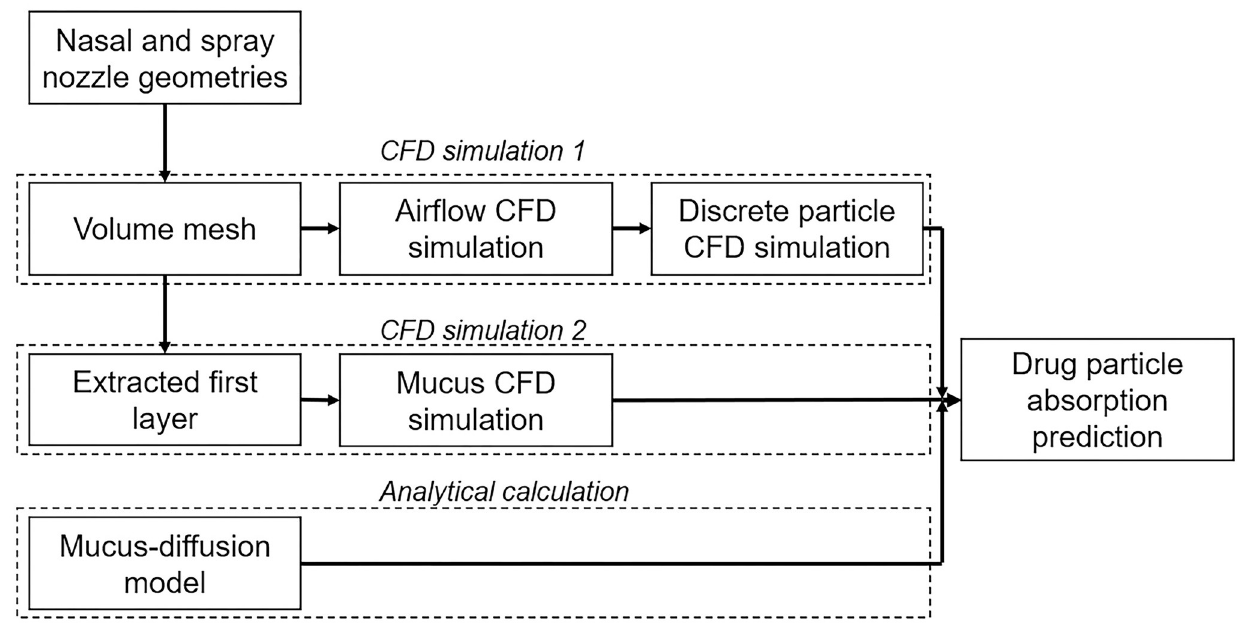
Fig 1. Integrated modelling framework for drug deposition and diffusion. The framework begins with CFD simulation 1—which computes the airflow field and spray particle deposition. CFD simulation 2 is a separate study that creates a mucus flow field; and the analytical calculation that combines data from the first two CFD